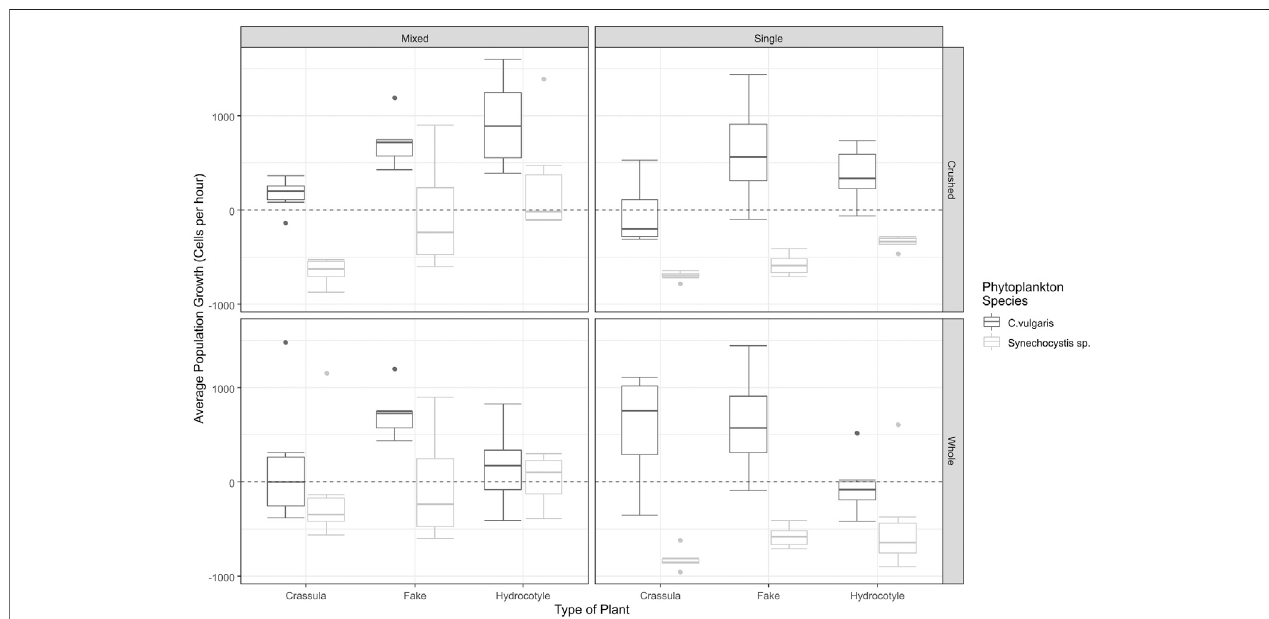
FIGURE1| Theaveragepopulationgrowth(cellsperhour)ofphytoplanktonundervaryingconditions.Theboxplotsindicatetheaveragepopulationgrowthofboth Chlorella (Dark Grey) and Synechocystis (Light Grey) under each set of conditions. The dotted line across the centre of each graph represents an average population growth of 0. The mean value is represented by the dark central line, the upper and lower bounds of the box represent the 75% and 25% percentile respectively. The whiskers represent the highest and lowest value observed within 1.5 times the inner quartile range. The circles represent datapoints that lie beyond 1.5 times the inner quartile range. Mixed and Single refer to co-culture and monoculture phytoplankton conditions, respectively. Crushed and Whole refer to the state of the plant.